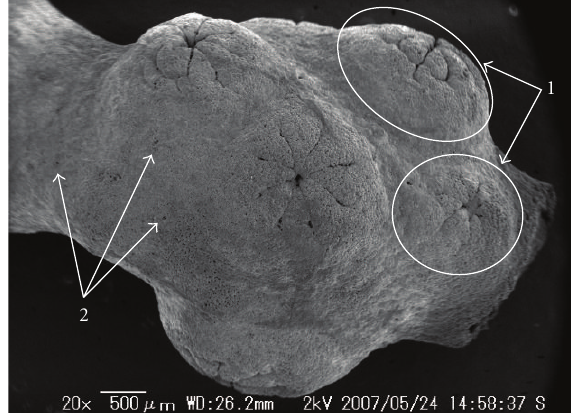
Figure 22: SEM image of coenenchyme surface of Corallium konojoi ; OCA-Cn20050619-020. 1: coenenchymal mounds, 2: siphonozooid openings.